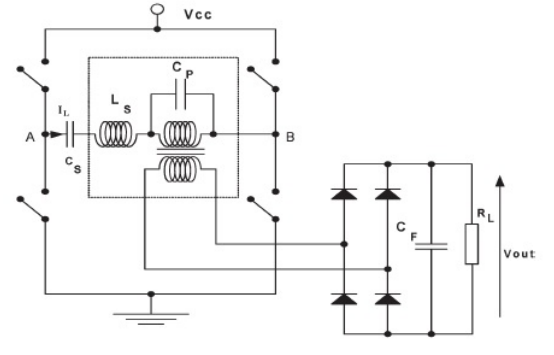
Figure 1. Parallel resonant converter [14].